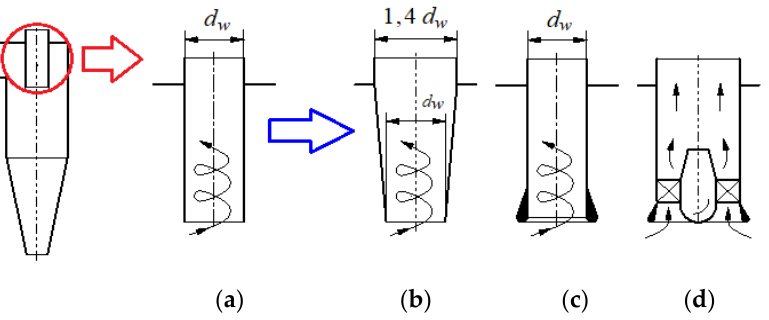
Figure 18. Available shapes of an inner cyclone tube: ( a ) cylindrical tube — standard, ( b ) conical tube, ( c ) cylindrical tube with streamlined inlet port and ( d ) tube with guide vanes. Figure made by author based on data from paper [40].